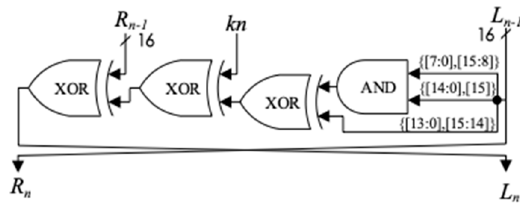
Figure 7. The structure of round function circuit.